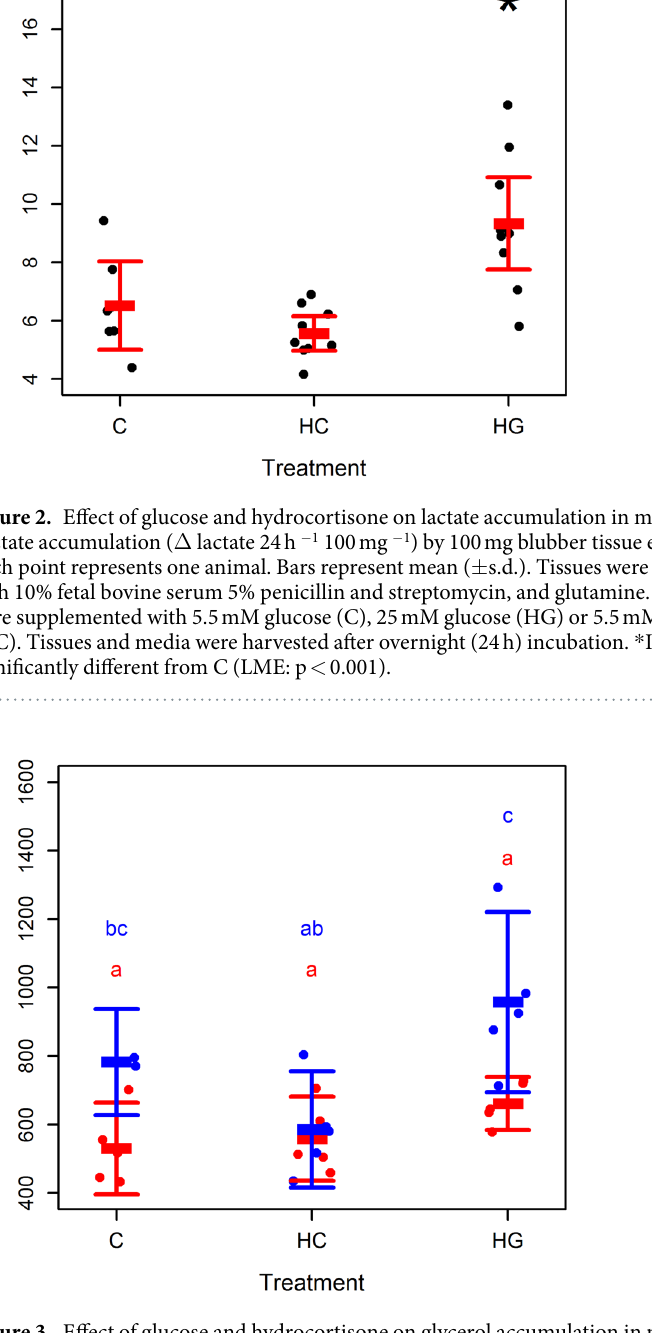
The mRNA abundance of Atgl (ANOVA: L ratio = 0.34; p = 0.557) or Hsl (ANOVA: L ratio = 0.40; p = 0.527), rate of glucose removal (ANOVA: L ratio = 2.53; p = 0.112) or condition (ANOVA: L ratio = 0.43; p = 0.514) did not explain any further variability in glycerol accumulation.